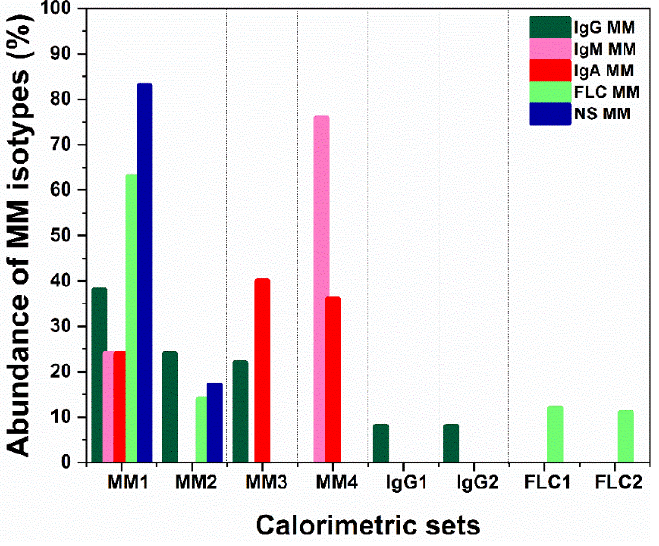
Figure 3. Distribution of each MM isotype among the different calorimetric sets defined in Figure 2. The color-coded bars represent the % of MM cases of certain isotype in each calorimetric set relative to the total number of cases for the same MM isotype. Table 2. Values of the calorimetric parameters T mHSA , T mIgs , c PHSA / Igs , T FM , ΔH cal , and the statistical parameters Pearson’s correlation coefficient (r), spatial distance metric (P) and similarity metric parameter ( ρ ) derived from comparison of the MM thermograms included in each of the calorimetric sets (defined in Figure 2) and test thermograms of healthy individuals with a reference set of control thermograms in the temperature interval 59 – 89 °C.